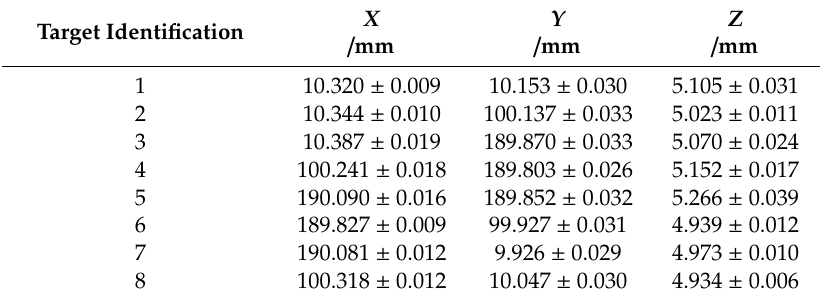
Figure 8. Dimensional measurement of the reference targets in the optical measuring machine. Table 1. Three-dimensional spatial coordinates of the reference targets—referential A.